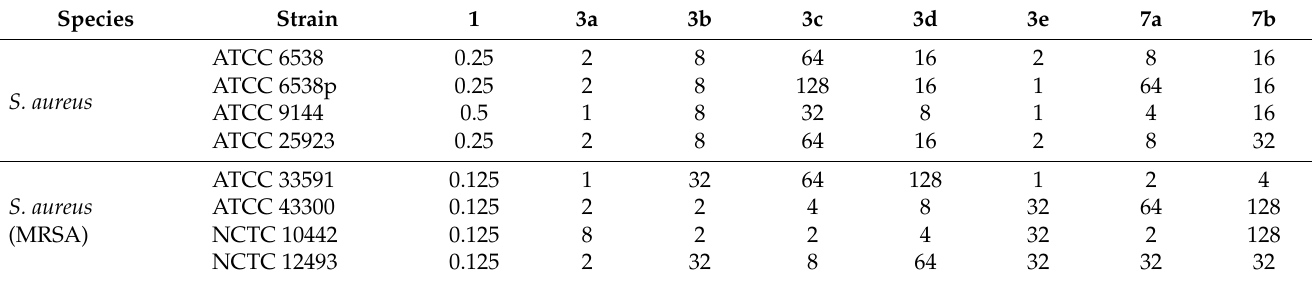
Table 1. MICs ( µ g/mL) for nadifloxacin ( 1 ) and synthesised glycosides ( 3a-e ) and ( 7a , b ) against drug-susceptible and -resistant S. aureus in